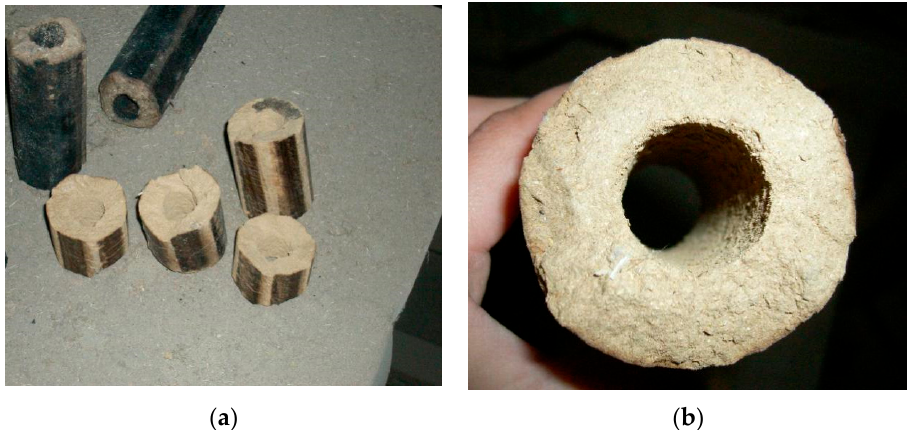
Figure 2. Exemplified extruded biofuel sticks of OSB residues and/or rice straw, ( a ) extruded biofuel sticks; ( b ) cross section.